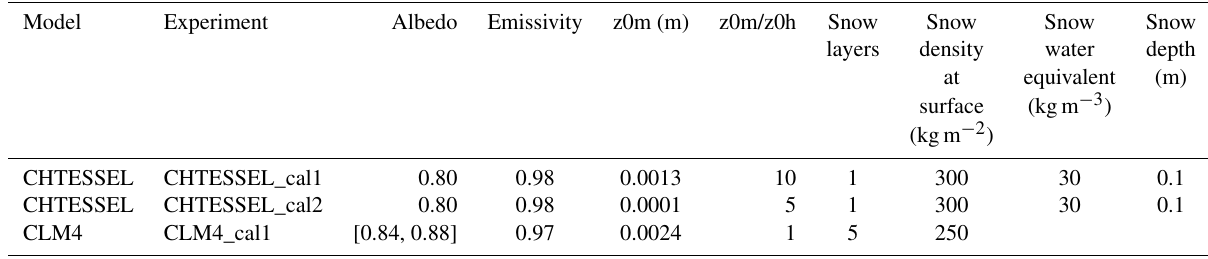
Table 4. Range of variation of model surface parameters for calibrated simulations. The values in square brackets indicate the values taken by a parameter when it is calculated by the model, while the single values are fixed during the